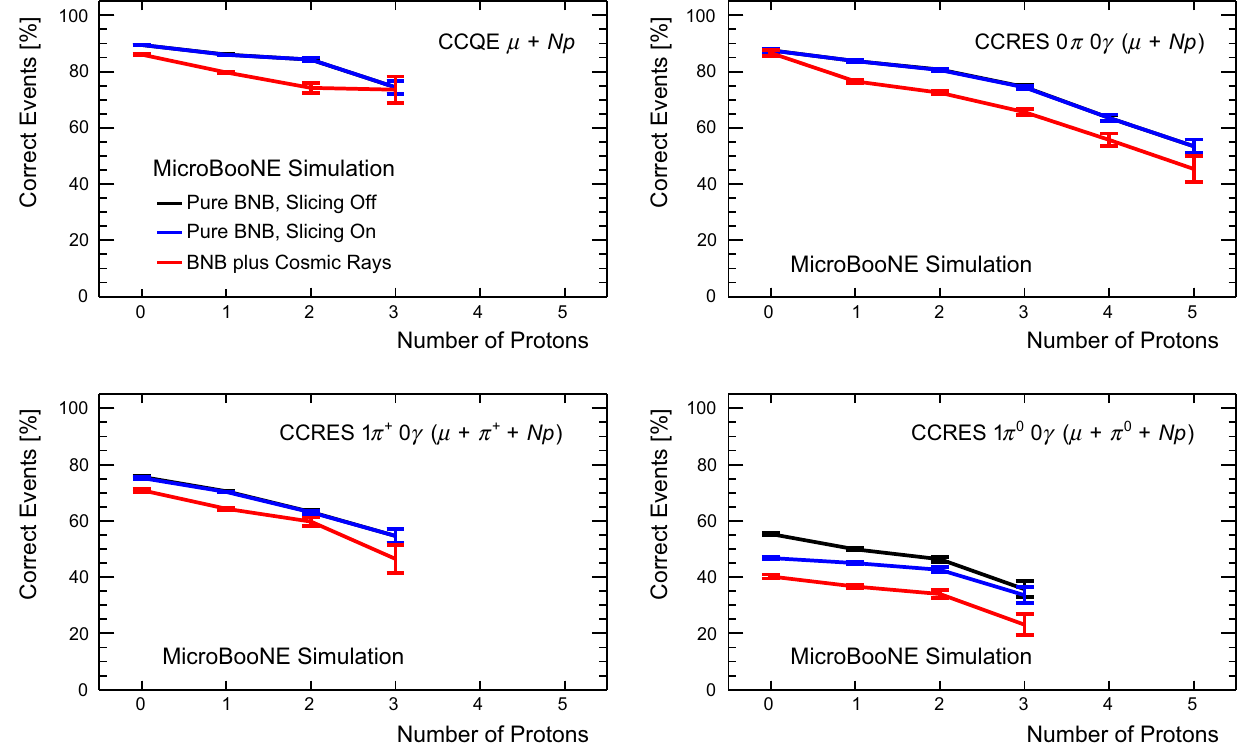
Fig. 21 The fraction of events deemed to have correct pattern recogni- tion, shown for a selection of different BNB interactions with exclusive final states. Results are shown separately for samples of pure BNB events, with and without the slicing algorithm enabled, and for BNB events in the presence of cosmic-ray backgrounds. Correct events are